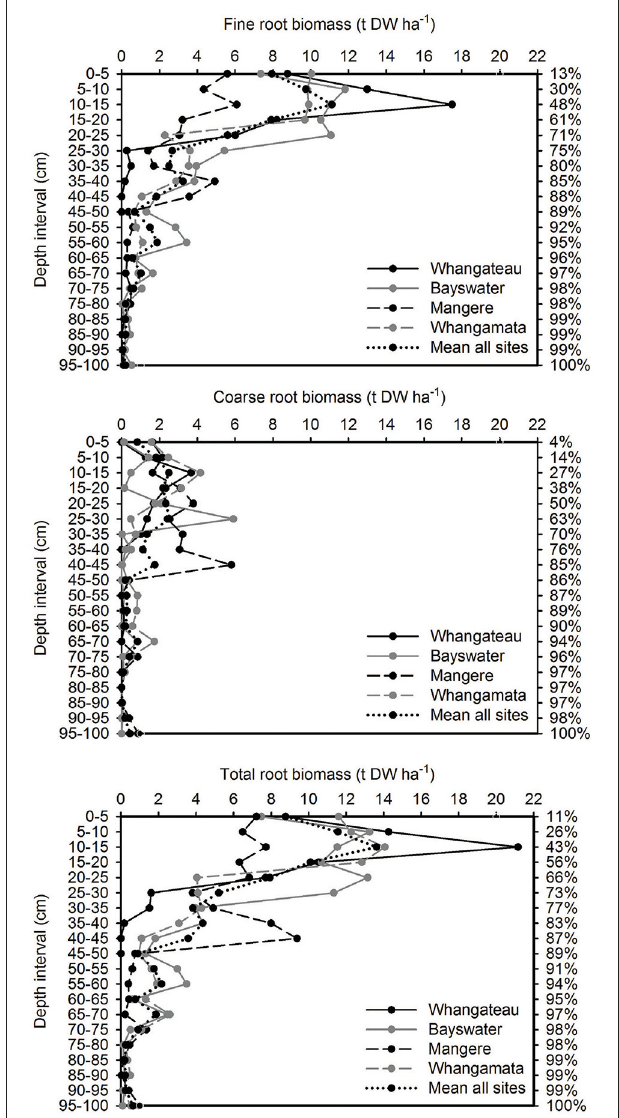
FIGURE 1 | Vertical distribution of root biomass based on 100cm depth cores ( n = 3 per site). Values are t DW ha − 1 for each 10cm depth interval. The cumulative percentage of root biomass captured at increasing depths throughout the sediment column (based on mean from all sites; relative to cores to 100cm) is shown on the right side of the